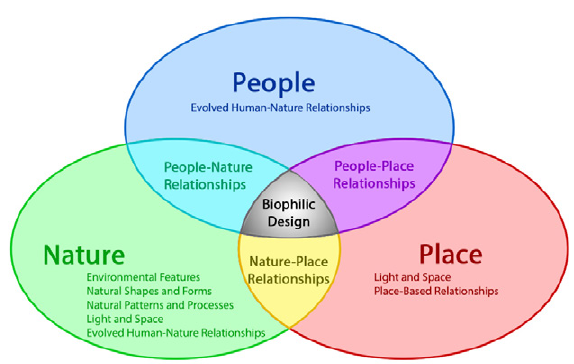
Figure 1. Three pillars and their intertwined relationships (diagram by the authors)